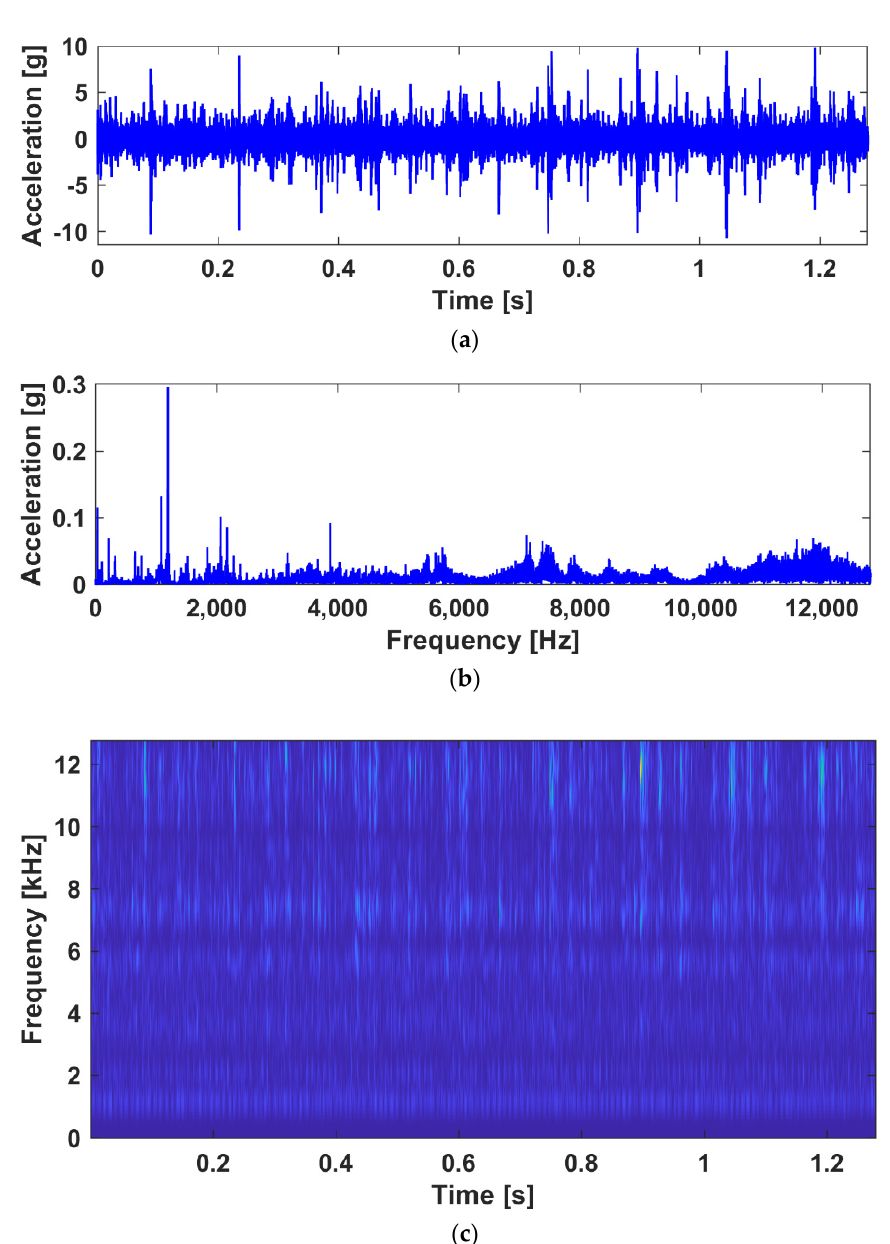
Figure 9. ( a ) The horizontal acceleration signal, ( b ) the amplitude spectrum, and ( c ) the corresponding STFT spectrogram in Case B .